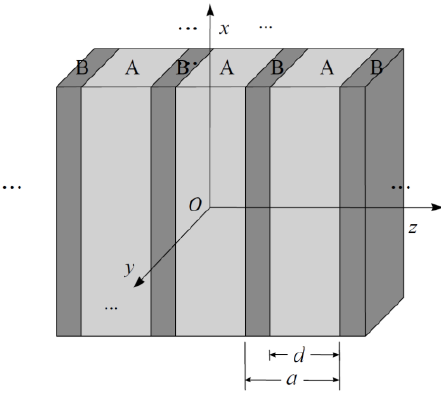
Figure 1. One-dimensional (1D) photonic crystal or bilayer superlattice with periodicity in z -direction.